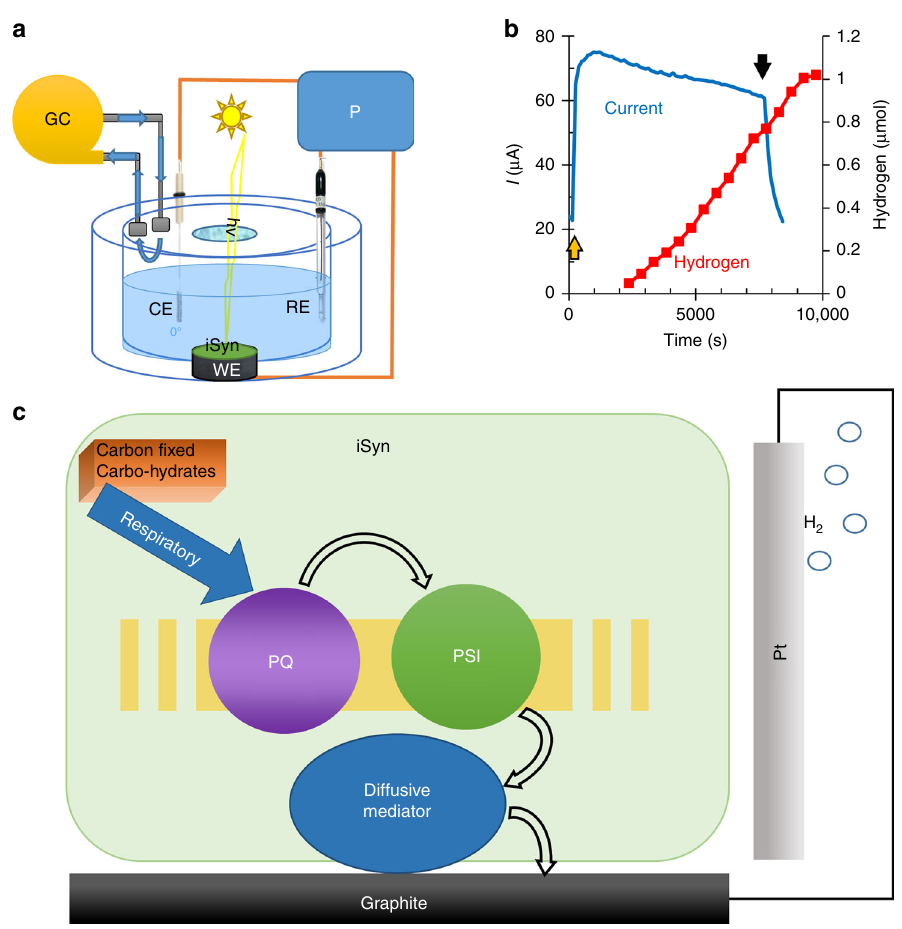
Fig. 6 Hydrogen is evolved on the cathode at a lower voltage than in water electrolysis. a Schematic drawing of the working setup for the hydrogen evolution measurements. The CA was measured at 50 mV (vs. Ag/AgCl/3 M NaCl) which corresponds to a voltage of 650 mV between the anode and cathode. b Simultaneous CA measurement of photocurrent (blue) and GC measurement of hydrogen production (red) measured as a function of time for the iSyn at 50 mV (vs. Ag/AgCl/3 M NaCl). c Schematic drawing of the electron fl ow from carbohydrates (internal or external) via the respiratory, light- driven activity of PSI, and an endogenous diffusive mediator to form hydrogen gas. The multiple electron transfer steps between the PQ and PSI are shown for simplicity as multiple curved